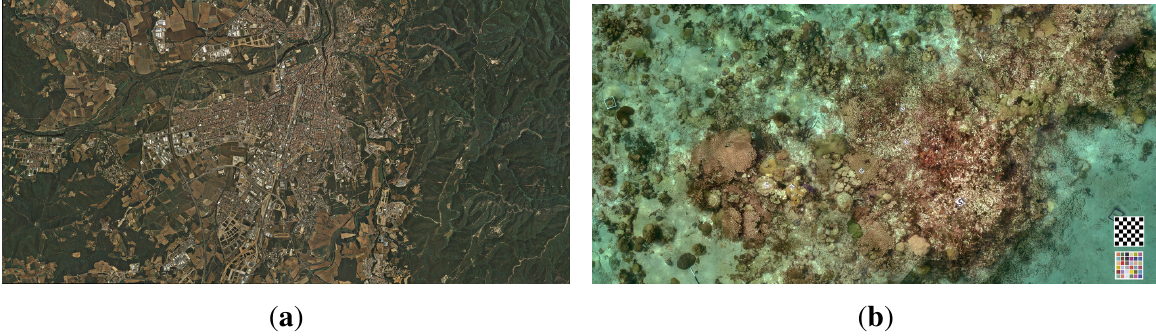
Figure 9. Posters used for the dry and underwater calibration, respectively. ( a ) Aerial image of the city of Girona used for both the intrinsic and extrinsic calibration procedures. The dimensions of the printed poster are 2.395 1.208 m; ( b ) Underwater image used for the × optimization of the housing parameters. The printed poster measures 7.09 3.49 m and was × placed in a flat area at the bottom of the test